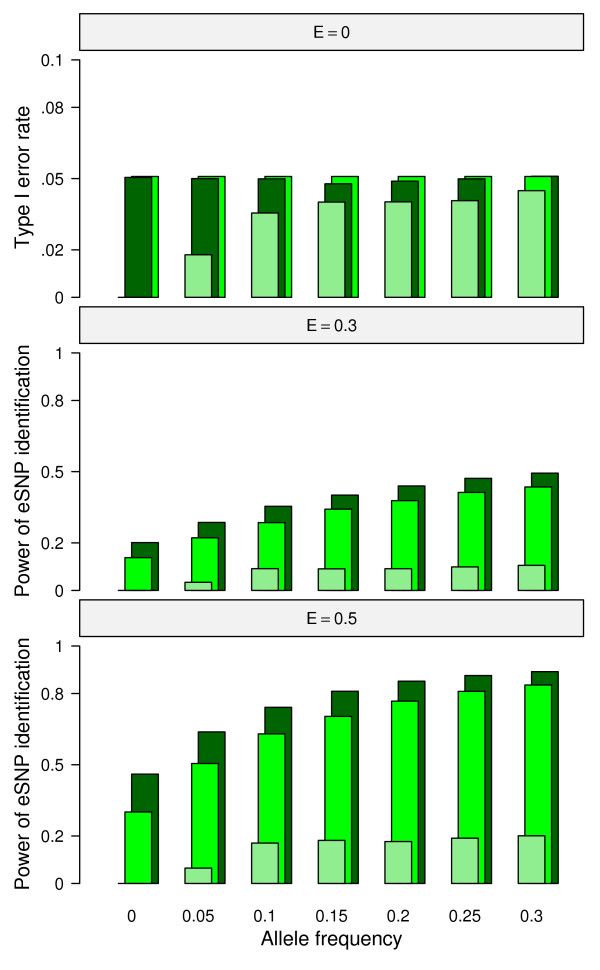
Simulations without inclusion of baseline differences II. The allele frequency of group 0 (P0) was analyzed with respect to type I error rate (upper panel, E = 0) and power (middle panel, E = 0.3; lower panel, E = 0.5) of eSNP identification, respectively. The three color bars represent the three different allele frequency differences as follows: light green, d = 0; green, d = 0.1; dark green, d = 0.2.